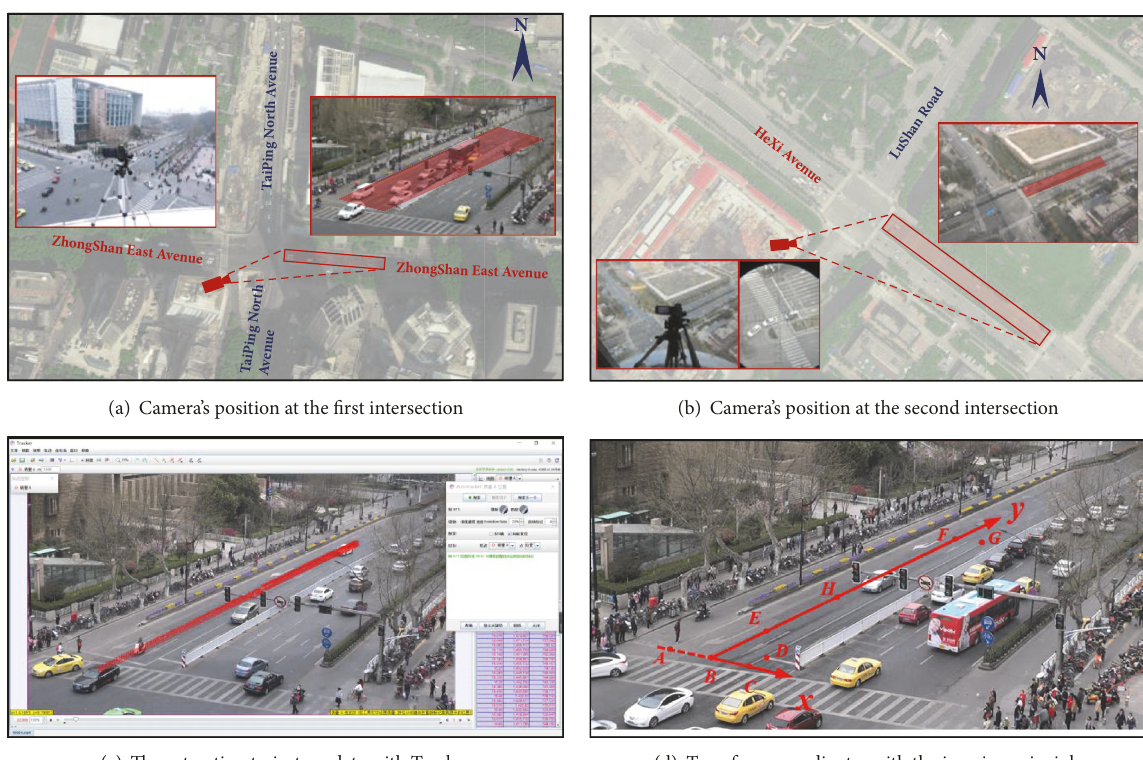
Figure 2: Data collection and